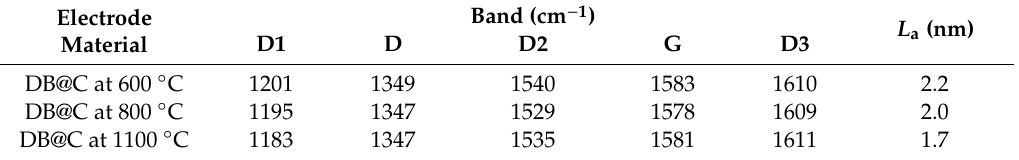
Table 3. The band position and L a parameters for DB@C pyrolysed at di ff erent